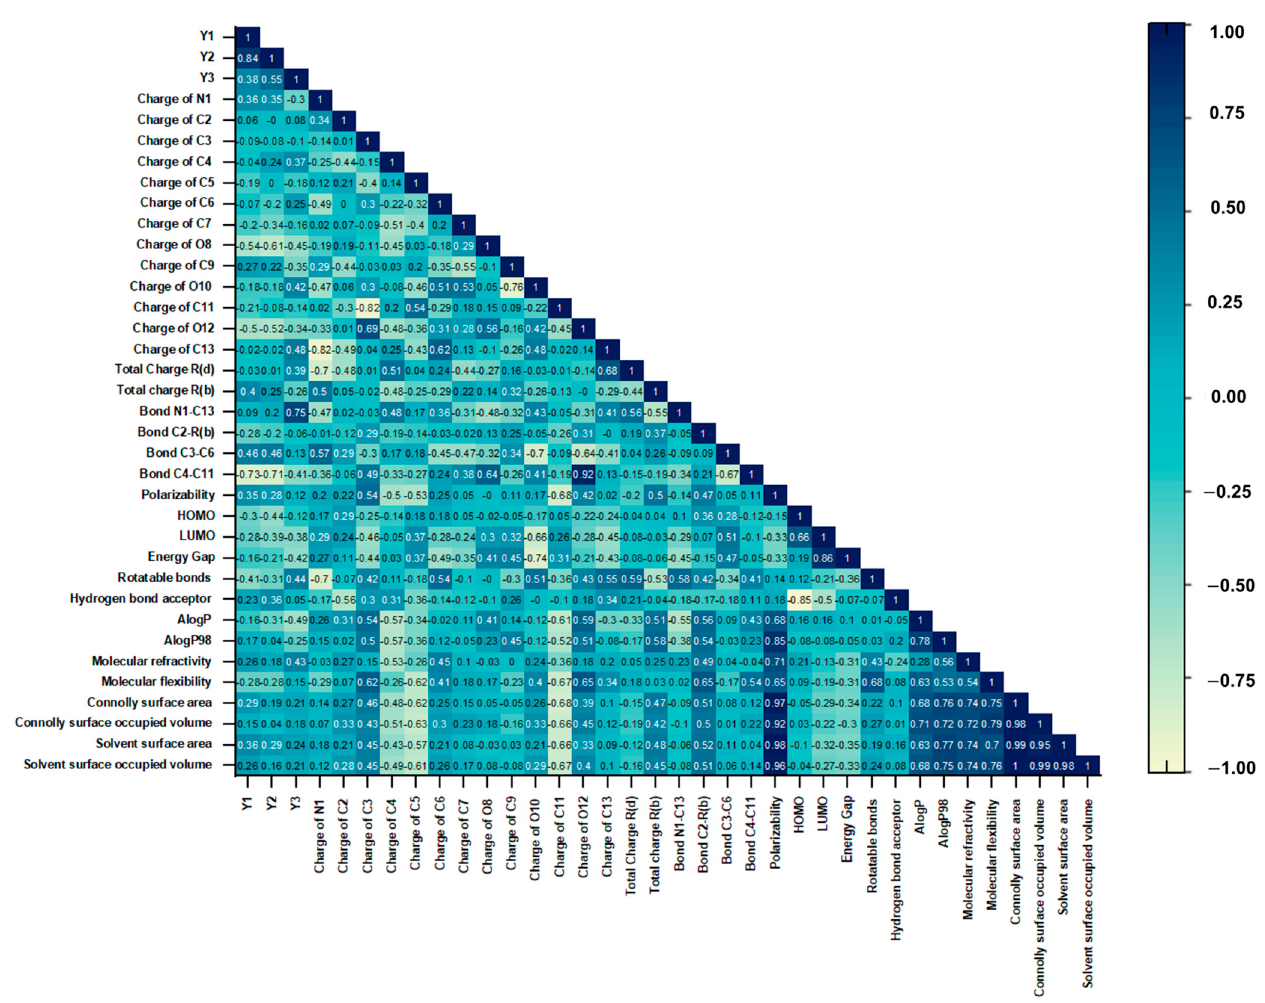
Figure 2. Pearson correlation coefficients of scavenging activities toward • OH ( Y1 ), O 2• − ( Y2 ),